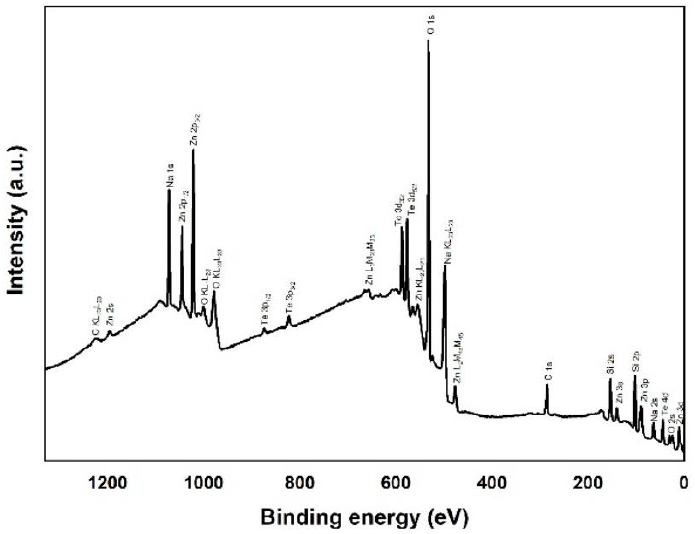
Figure 16. XPS survey spectrum for the sample prepared using a substrate temperature of 570 °C (K570).